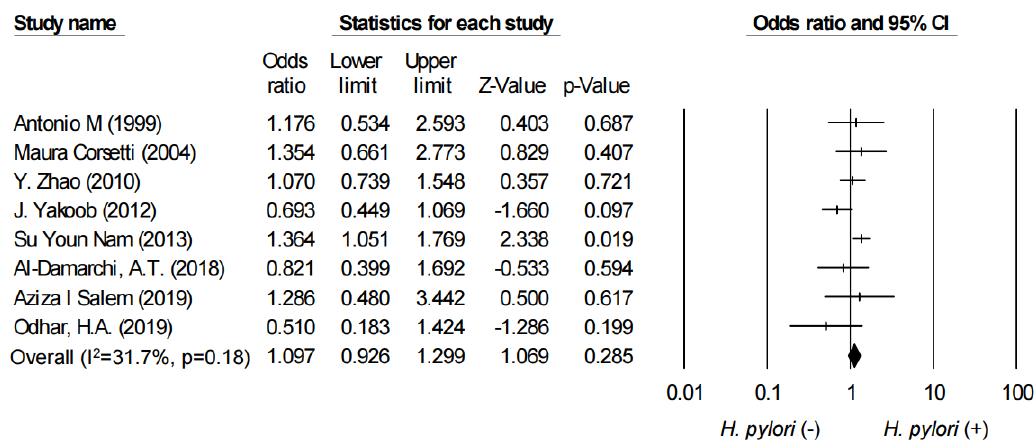
Figure 3. Forest plot evaluating the combined OR between IBS and according to Rome criteria and H. pylori infection.